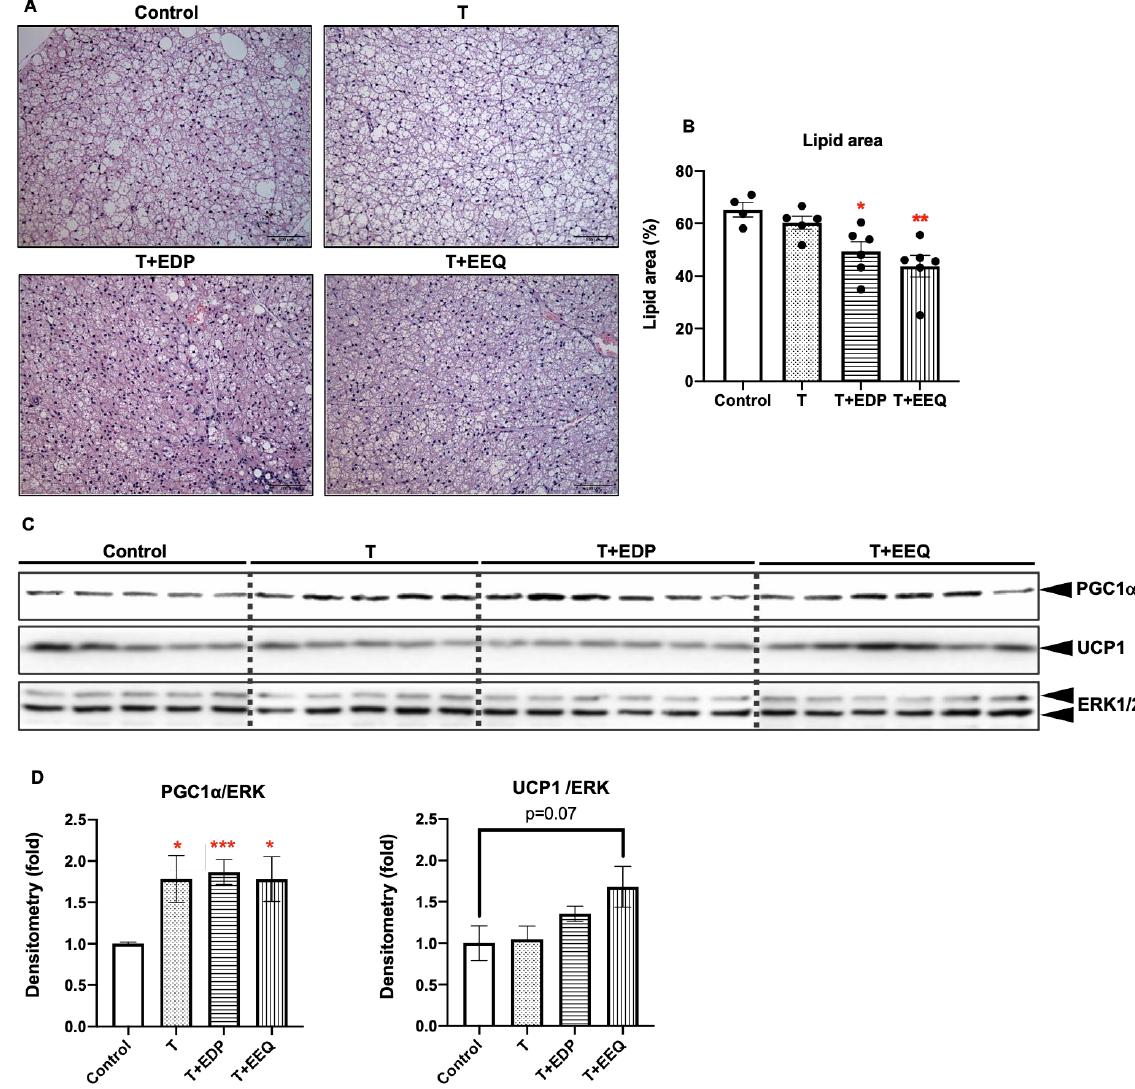
Figure 4. 17,18-EEQ or 19,20-EDP combined with t -TUCB delivered via mini osmotic pump decreased the lipid accumulation and regulated thermogenic gene expression in the iBAT of diet-induced obesity. After termination, the iBAT tissue slides from mice were stained with hematoxylin and eosin (H&E; A ), and the % area occupied by lipid from 2 – 3 fields per slide per mouse ( n = 5) were analyzed using Image J software ( B ). Scale bars = 100 µm. Protein expression of PGC1 α , UCP1, and the loading control ERK in the iBAT of mice in the control, T, T + EDP, and T + EEQ group ( C ), and their densitometry ( D , E ) are shown; Bar graphs show the normalized densitometry for PGC1 α /ERK1/2 and UCP1/ERK1/2. Data = the mean ± SEM ( n = 5 – 6). *, **, and *** = p < 0.05, p < 0.01, and p < 0.001 compared to the controls, respectively.